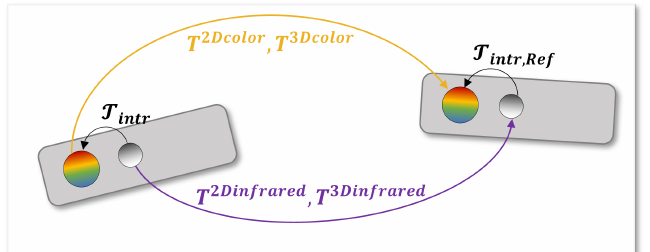
Figure 3. Conceptual meaning of the application of the transformation matrices obtained from the proposed calibration techniques. The transformation process using matrices with color geometry is marked in yellow, whereas the transformation process using matrices with infrared geometry is marked in